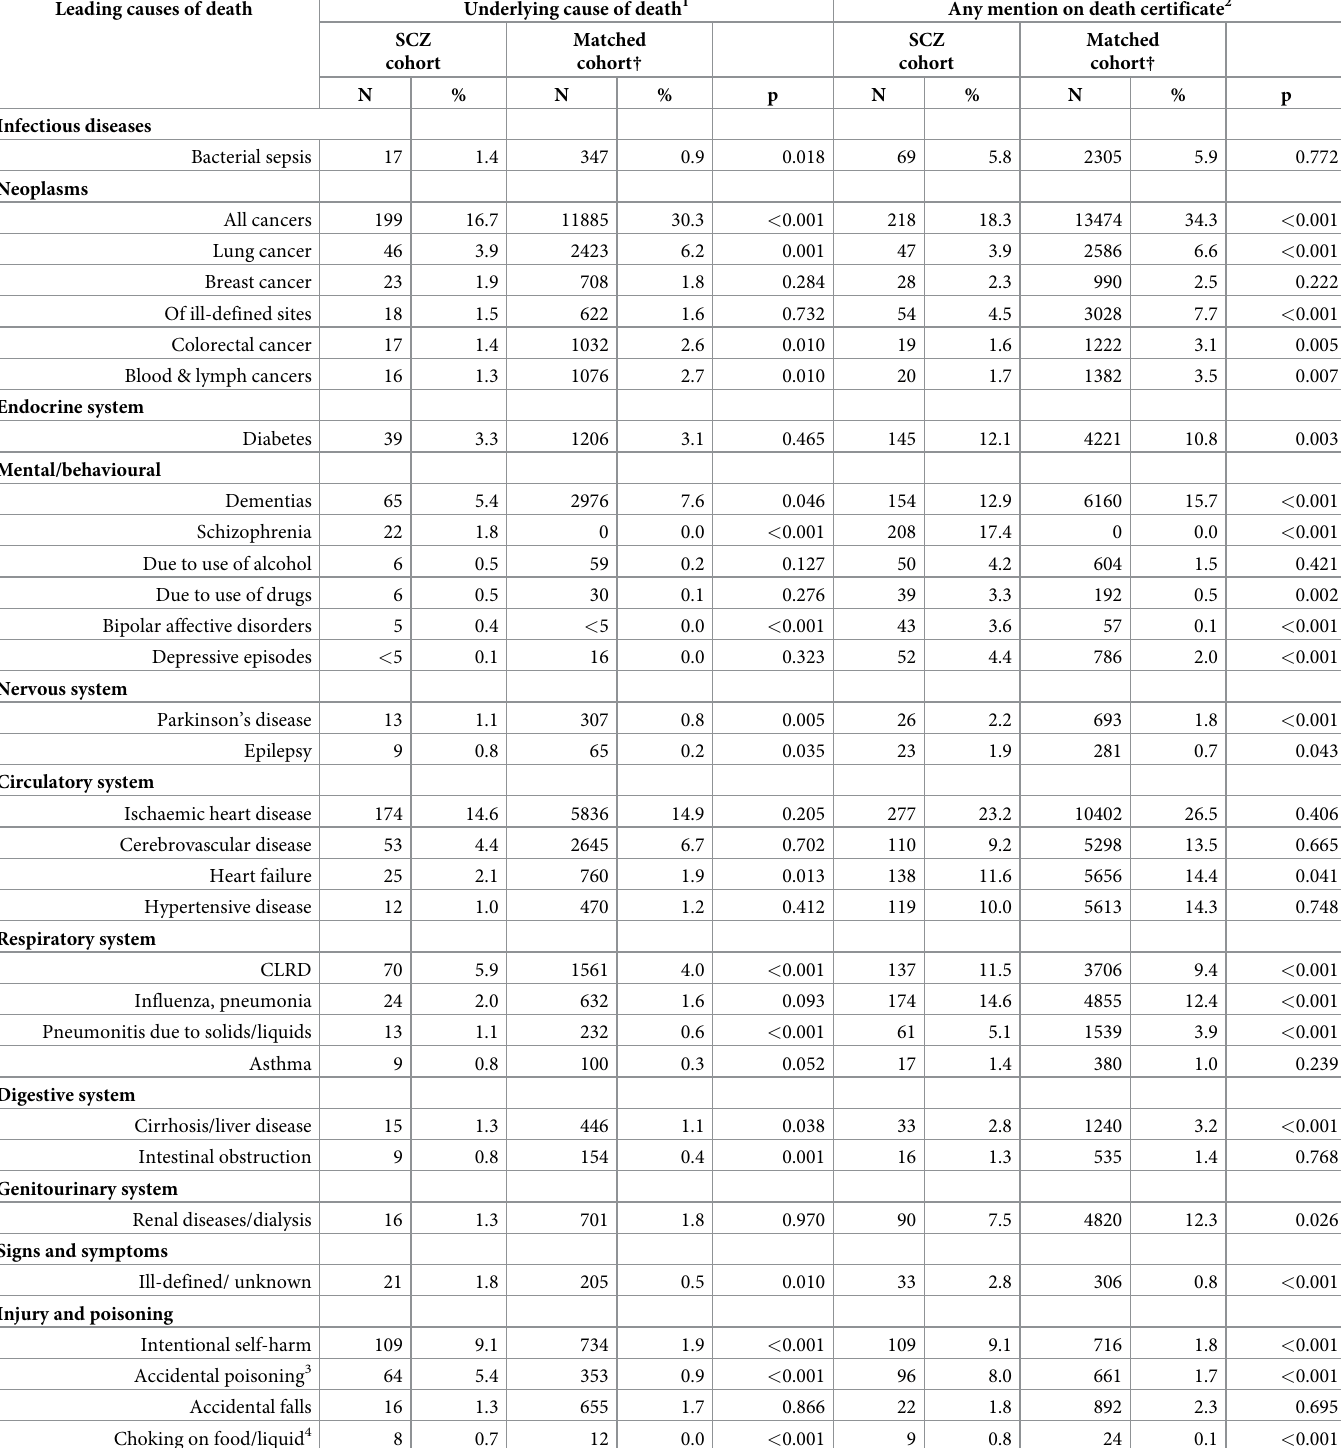
Table 2. The leading causes of death for decedents with schizophrenia (n = 1194) compared against decedents in the matched control cohort (n = 39,265) by under- lying cause or any mention of the cause on the death certificate. Leading causes of